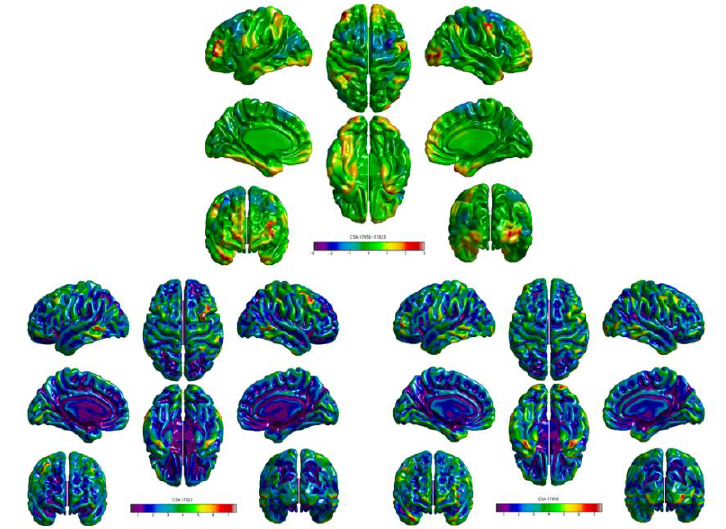
Bottom panel: distribution of cortical surface area values across the brain for two young human beings (A, left and B, right) with exactly the same scores in fluid, crystallized, and visuospatial intelligence. Top panel: differences between A and B in the distribution of cortical surface area. There is, for instance, a substantial difference in the left frontal lobe, but this is not leading to any difference in Gf, Gc, or